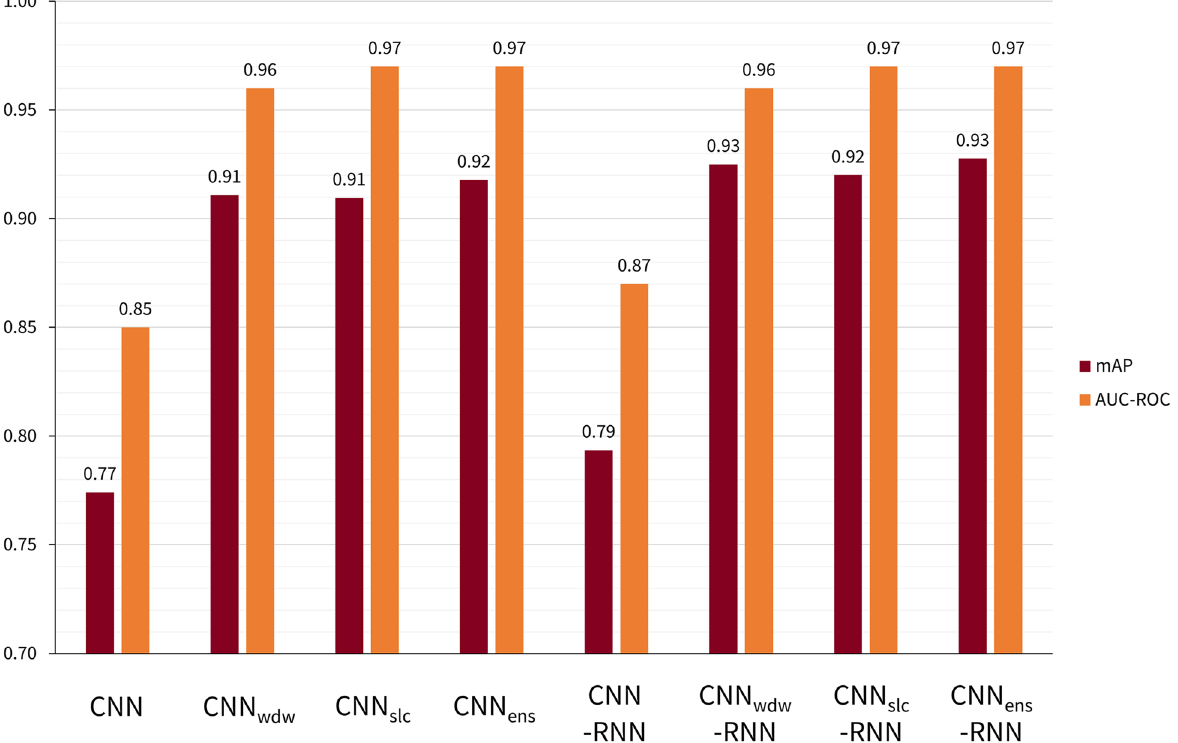
Fig. 1 Comparison of model performances with different preprocessing and addition of an RNN. CNN denotes the model composed of a CNN, with no preprocessing image techniques or RNN added. CNN wdw denotes the CNN model trained only with the image windowing preprocessing pipeline. CNN slc denotes the CNN model trained only with the adjacent slice concatenation preprocessing pipeline. CNN ens denotes the ensemble model combining CNN wdw with CNN slc . CNN wdw -RNN denotes the CNN wdw model joined to an RNN. CNN slc -RNN denotes the CNN slc model joined to an RNN. CNN ens -RNN denotes the CNN ens model joined to an RNN. AUC-ROC Area under the receiver operating characteristic curve, CNN Convolutional neural network, mAP Average precision score (microaveraged across all six haemorrhage classes), RNN Recurrent neural